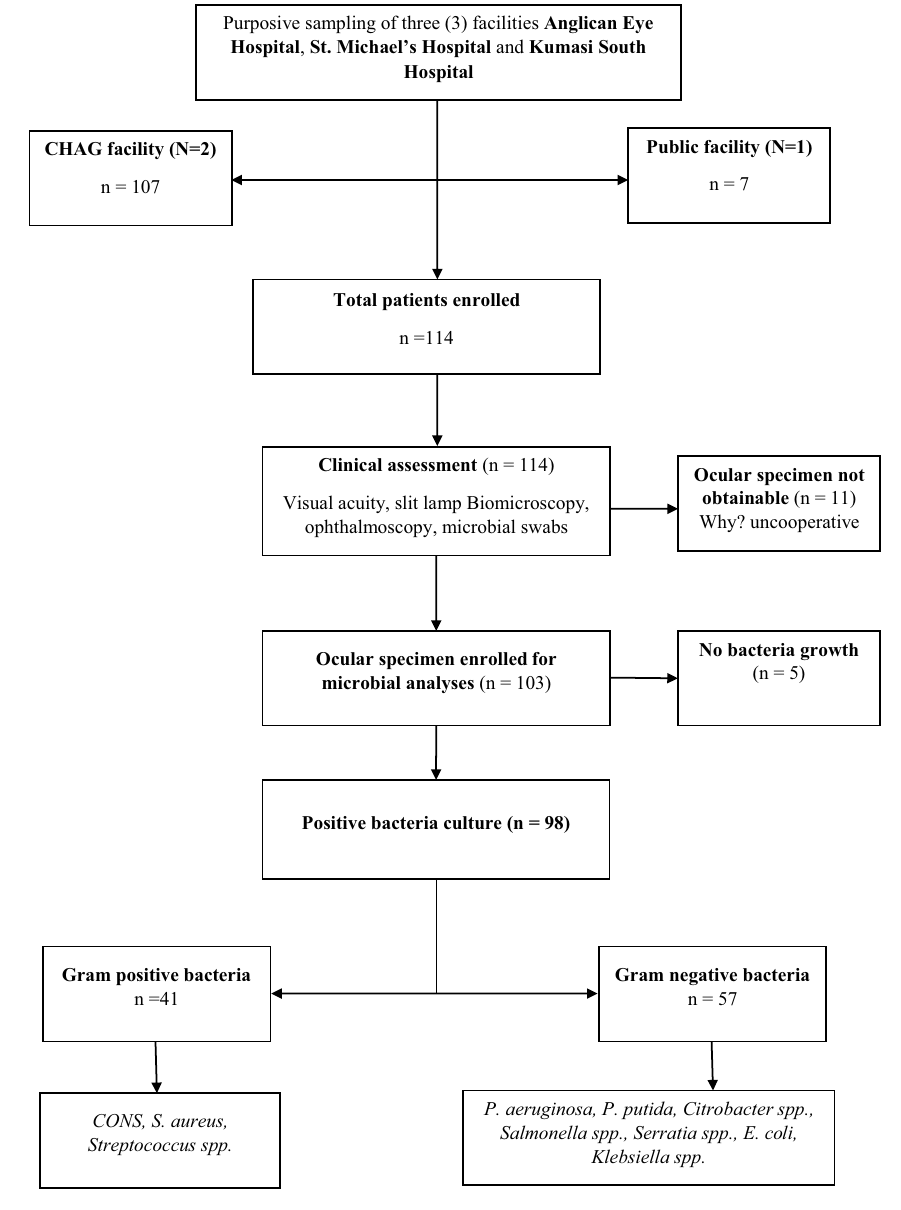
Figure 1. Flow diagram illustrating study